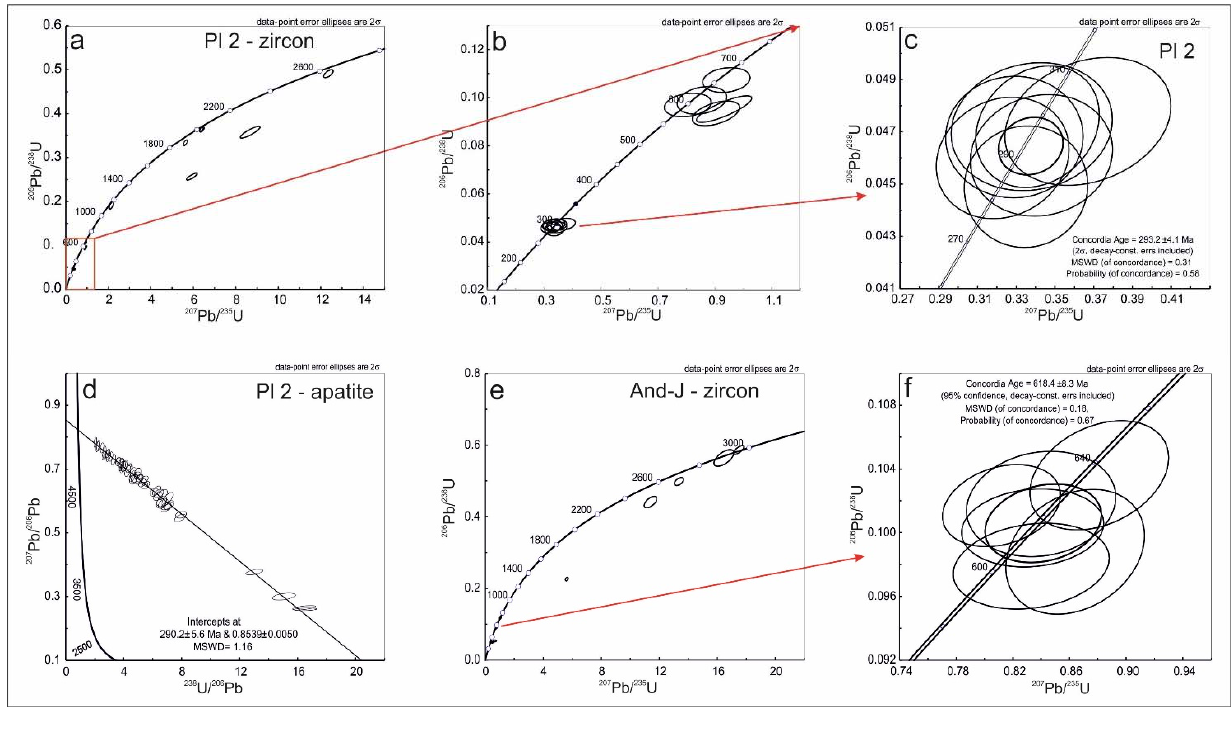
Figure 6. Concordia plots of LA-ICP-MS zircon and apatite analytical results: ( a ) microgranitoid from Pluskawka with inserts of Neoproterozoic zircon cores and Variscan zircons ( b , c ); ( d ) Tera–Wasserburg concordia plot for apatite from the Pluskawka microgranitoid; ( e ) concordia plot of the zircon crystals from the andesite, with an insert for Neoproterozoic inherited crystals age ( f ).